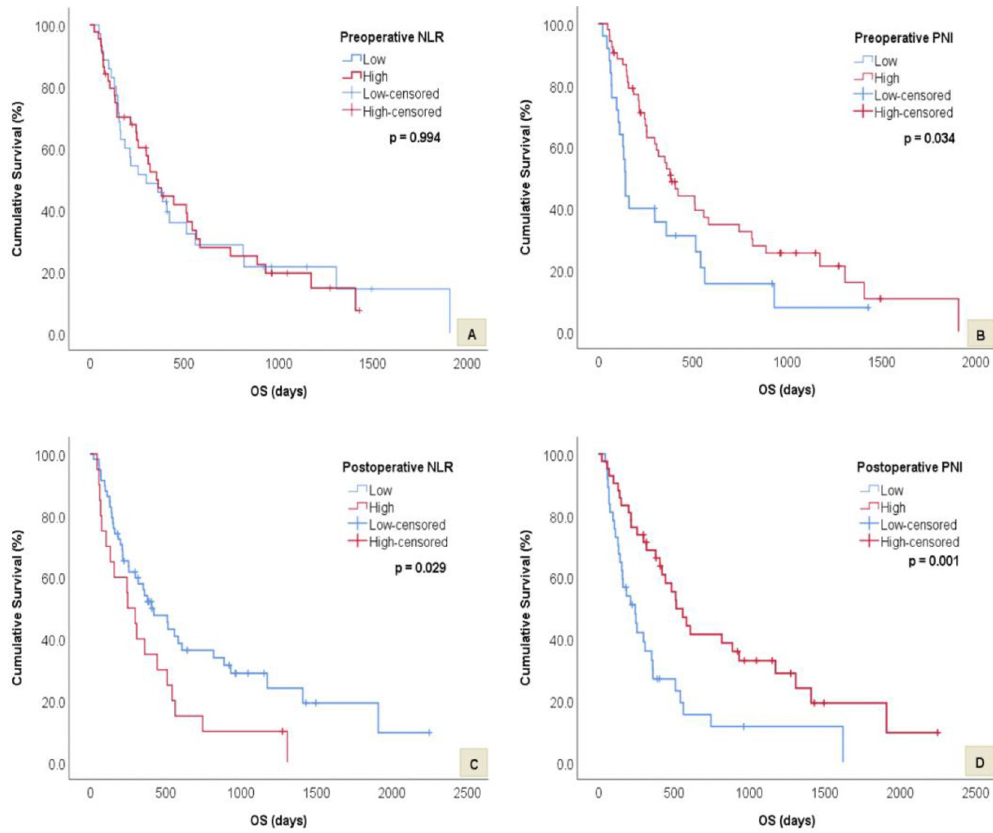
Fig 2. Kaplan-Meier survival curves and log rank tests showing differences in OS between low and high preoperative and postoperative NLR and PNI groups. A) Difference in OS between low and high preoperative NLR. B) Difference in OS between low and high preoperative PNI. C) Difference in OS between low and high postoperative NLR. D) Difference in OS between low and high postoperative PNI.